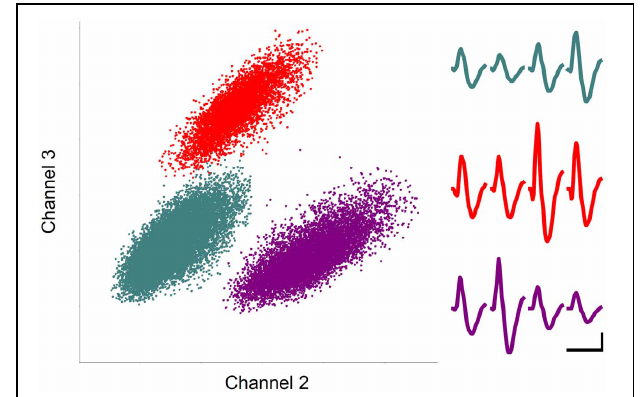
FIGURE 3 | Unit recording example. Each unit cluster is indicated in different color. Horizontal and vertical axes indicate the amplitudes of spike signals recorded through two different channels of a tetrode. Averaged spike waveforms recorded through four tetrode channels are shown in corresponding colors on the right. Calibration: 1ms and